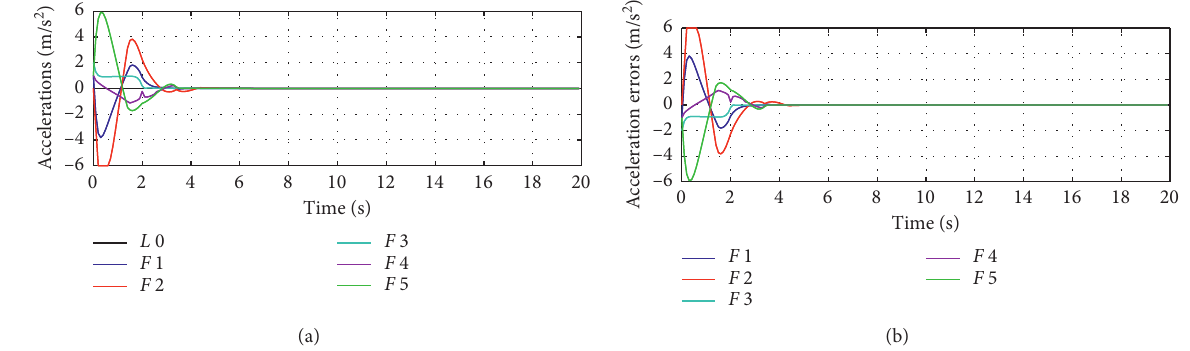
Figure 4: Accelerations and acceleration errors of the vehicles.